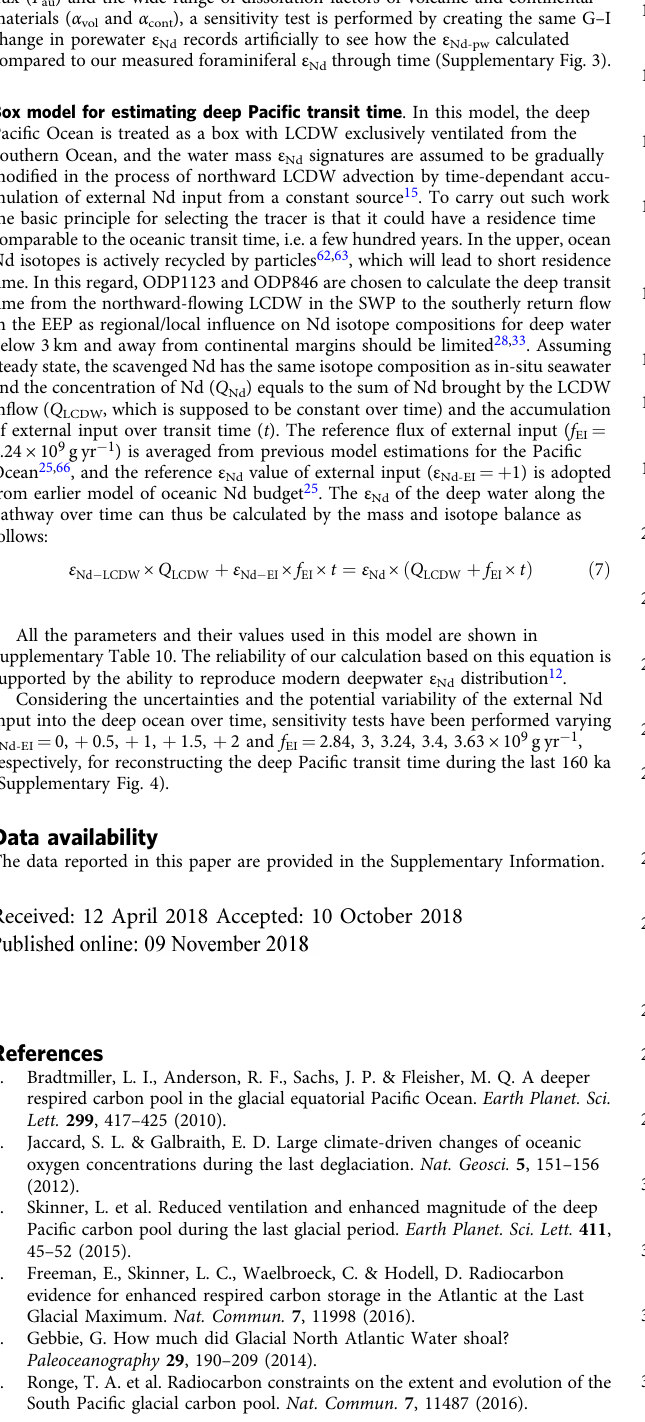
supported by the ability to reproduce modern deepwater ε Nd distribution 12 . Considering the uncertainties and the potential variability of the external